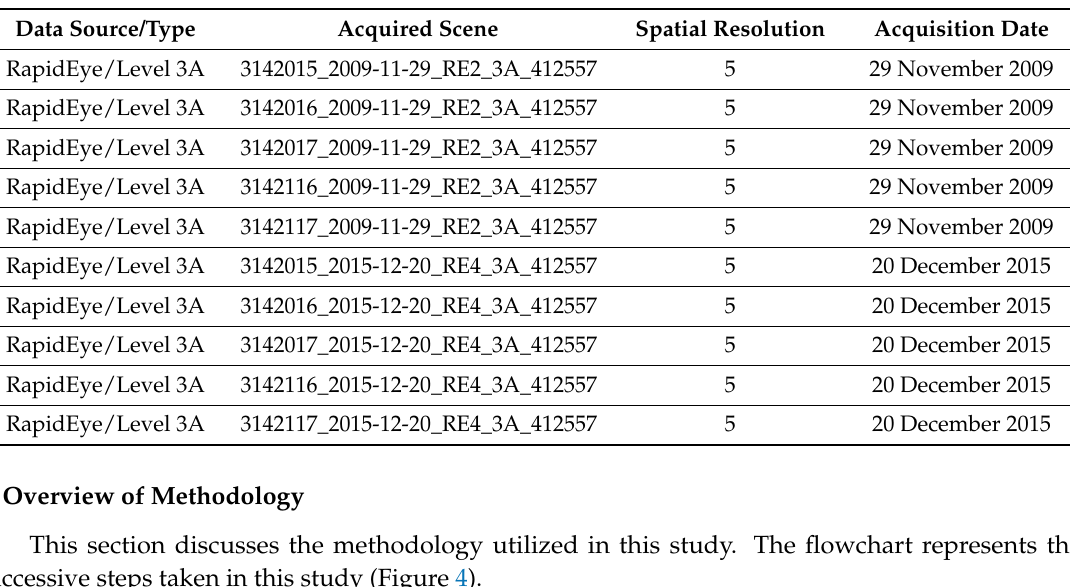
Table 1. Satellite imagery description.